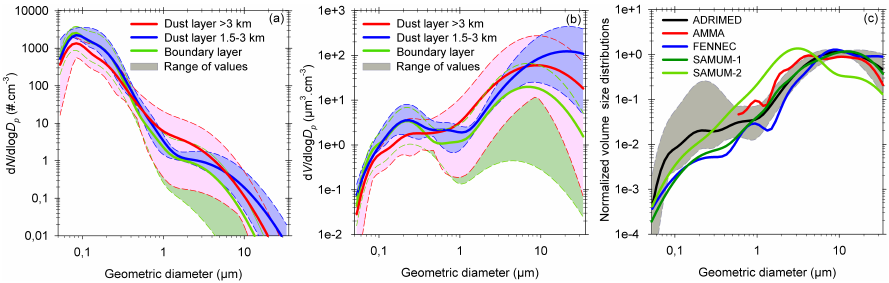
Figure 7. Particle size distributions obtained in the dust layers during ADRIMED for (a) number distribution, (b) volume distribution and (c) volume distribution normalized by the total volume concentration. In panels (a) and (b) , size distributions are classified as a function of the altitude of the layer: dust layer above 3kma.s.l. (red), dust layer between 1.5 and 3km a.s.l. (blue) and the boundary layer below 1km (green). The shading represents the range throughout the campaign. In panel (c) , the mean (dark line), minimum and maximum normalized size distributions (grey shading) observed above 1.5km during the ChArMEx/ADRIMED campaign are compared with those observed in the source region during the airborne campaigns AMMA (red line, Formenti et al., 2011a), FENNEC (blue line; Ryder et al., 2013b) and SAMUM-1 (dark green line; Weinzierl et al., 2009), as well as with measurements at Cape Verde region during SAMUM-2 campaign (light green line; Weinzierl et al., 2011). The AMMA curve (Formenti et al., 2011) is curtailed to 0.3µm since there was no measurement below this size during the campaign.